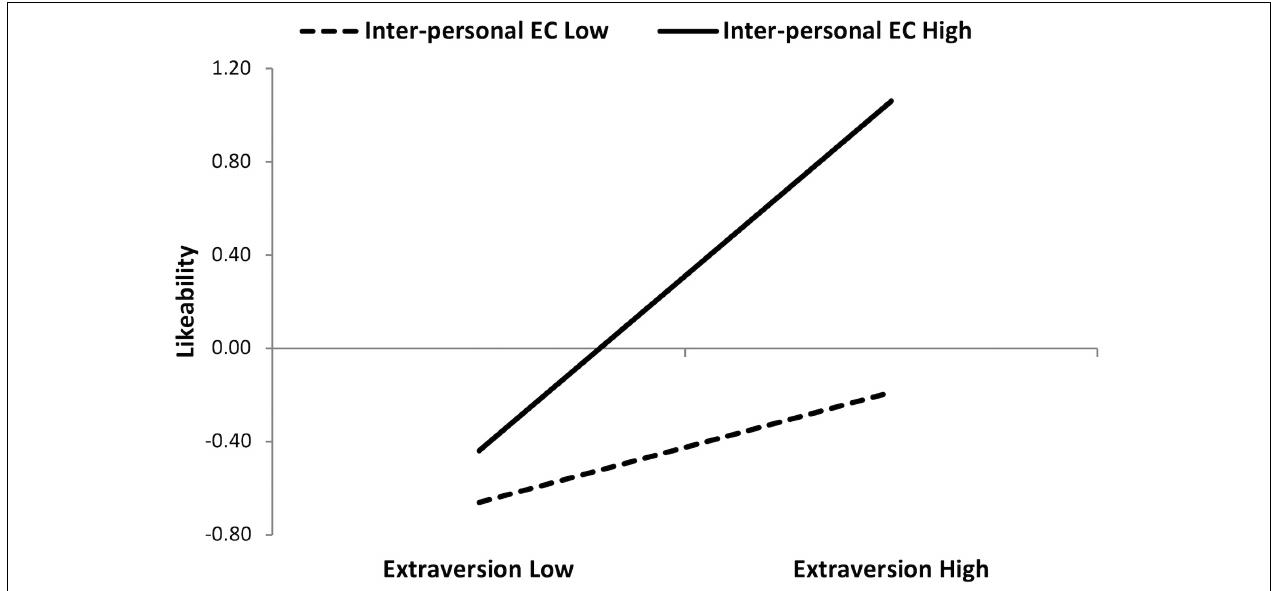
FIGURE 1 | Peer-rated likeability as a function of extraversion and interpersonal emotional competence. Low extraversion is defined as a mean -1 standard deviation from the mean; high extraversion is defined as a mean +1 standard deviation. Note that this high/low split is for illustrative purposes only; the moderation analyses conducted use all variables as continuous